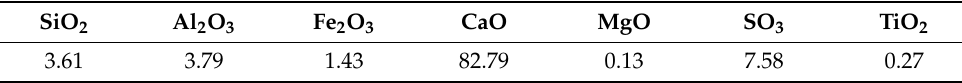
Table 1. Mass percentage content of each component of expansive agents